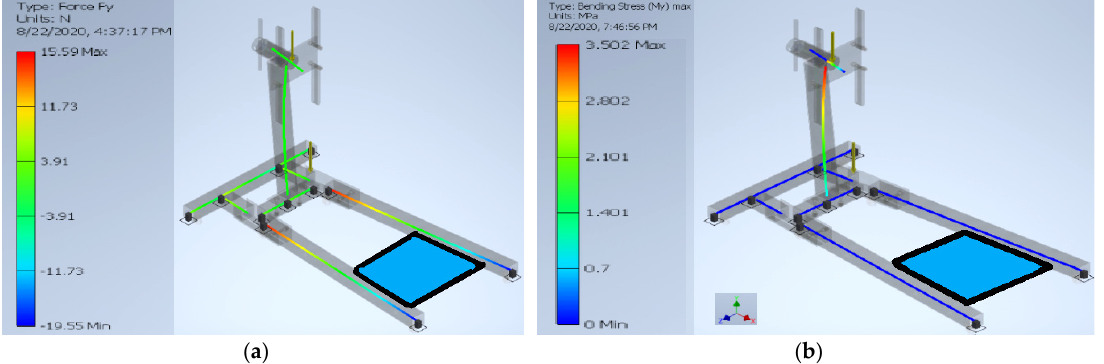
Figure 11. Virtual analysis of the sensor’s support regarding: ( a ) vertical force; ( b ) bending stress.